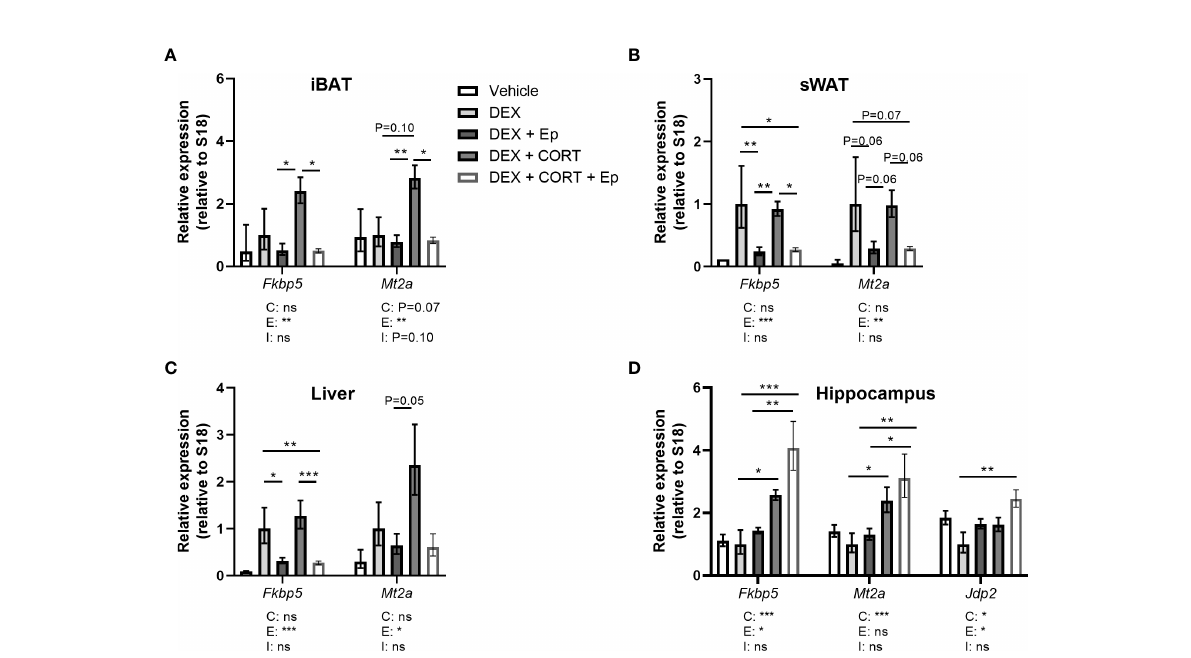
FIGURE 9 Eplerenone prevents additional induction by corticosterone add-on on target gene expression. Mice received a high-fat diet mixed with vehicle (VEH), dexamethasone (DEX) with or without eplerenone (Ep) and were subcutaneously implanted with corticosterone (CORT) or vehicle pellets for 3.5 weeks. (A – C) Ep reduced the induction of Mt2a and Fkbp5 expression by DEX and DEX + CORT in interscapular brown adipose tissue (iBAT), gonadal white adipose tissue (gWAT) and liver. (D) Fkbp5, Mt2a and Jdp2 expression was increased by DEX + CORT, and more so by DEX + CORT + Ep in the hippocampus. The vehicle group was excluded from statistical analyses. Statistical signi fi cance was calculated using 2- way ANOVA analysis. Depicted below the graphs are the P-values of the ANOVA tests for either CORT (C), Ep (E) or the interaction between CORT and Ep (I). *P < 0.05, ** P < 0.01, ***P < 0.001. 'ns' means 'not signi fi